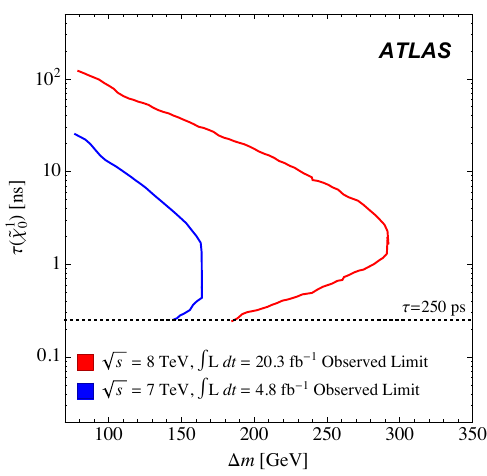
Figure 6 . Remapping of the ATLAS displaced diphoton + missing energy search into the simpli(cid:12)ed model variables of Bino lifetime, (cid:28) , and Bino-gravitino mass splitting (cid:1) m . The ATLAS search was presented in terms of SPS8 (see text for details).